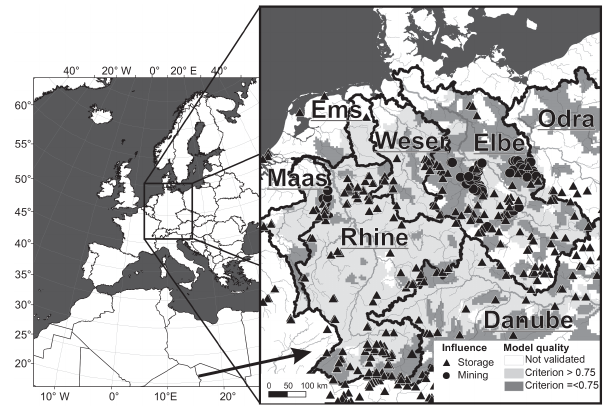
Figure 1. Model domain (left map) and validation results (right map) for river basins of the conceptual hydrological model LARSIM-ME. Grey scales in the right panel show classified val- ues of the coefficient of determination ( R 2 ) of daily flow values (November 1976 to October 2005). Locations of dams and min- ing were compiled from various sources (among others; Hydrolog- ical Atlas of Germany (BMU, 2003); Global Reservoir and Dam Database, GRanD; Lehner et al., 2011). Arrow marks the region selected as a case